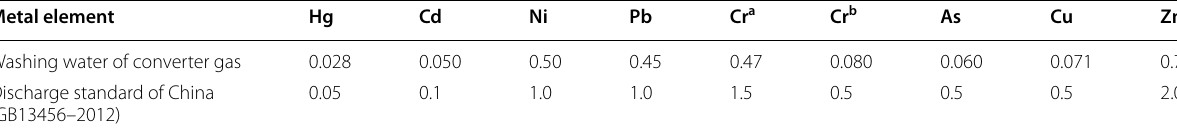
a total content of Cr; b content of Cr (VI)